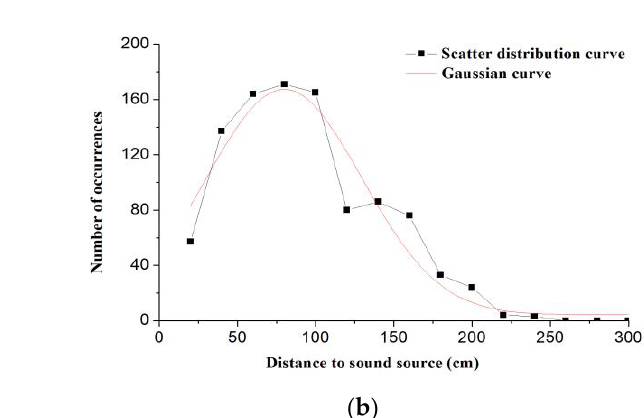
Figure 6. Spatial distribution frequency of juvenile Pagrus major in the control tank ( a ) and test tank ( b ) after eight days of training with 400 Hz square-wave continuous tones.